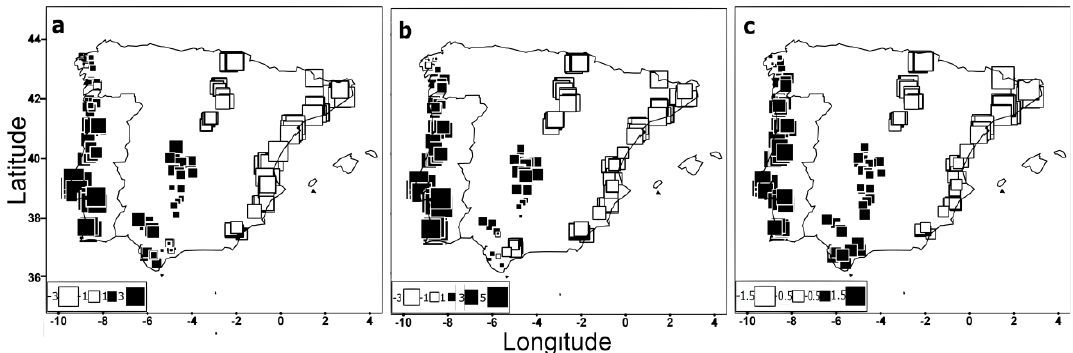
Figure 4. Global structure displayed by the 711 colonies (from 23 sampling sites located in the Atlantic, Central, and Mediterranean transects) after the spatial principal component analysis (sPCA). Global scores (first principal component) obtained from (a) wing geometric morphometrics of drones, (b) wing geometric morphometrics of workers, and ( c ) SNPs genotyped in drones by Chávez-Galarza, et al. [35]. Squares represent population scores and are spatially arranged according to the geographical coordinates of the colonies. Large black squares indicate colonies well differentiated from those denoted by large white squares whereas small squares indicate a lower degree of differentiation.